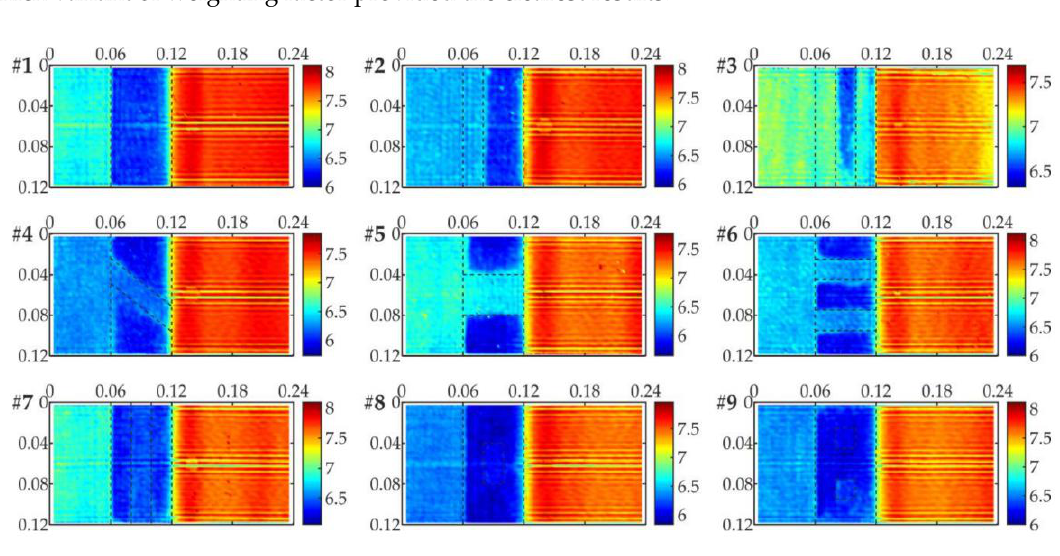
Figure 11. WRMS maps (values in (m/s)) for specimens #1–#9 ( T = 3.00 ms, w r = r 2